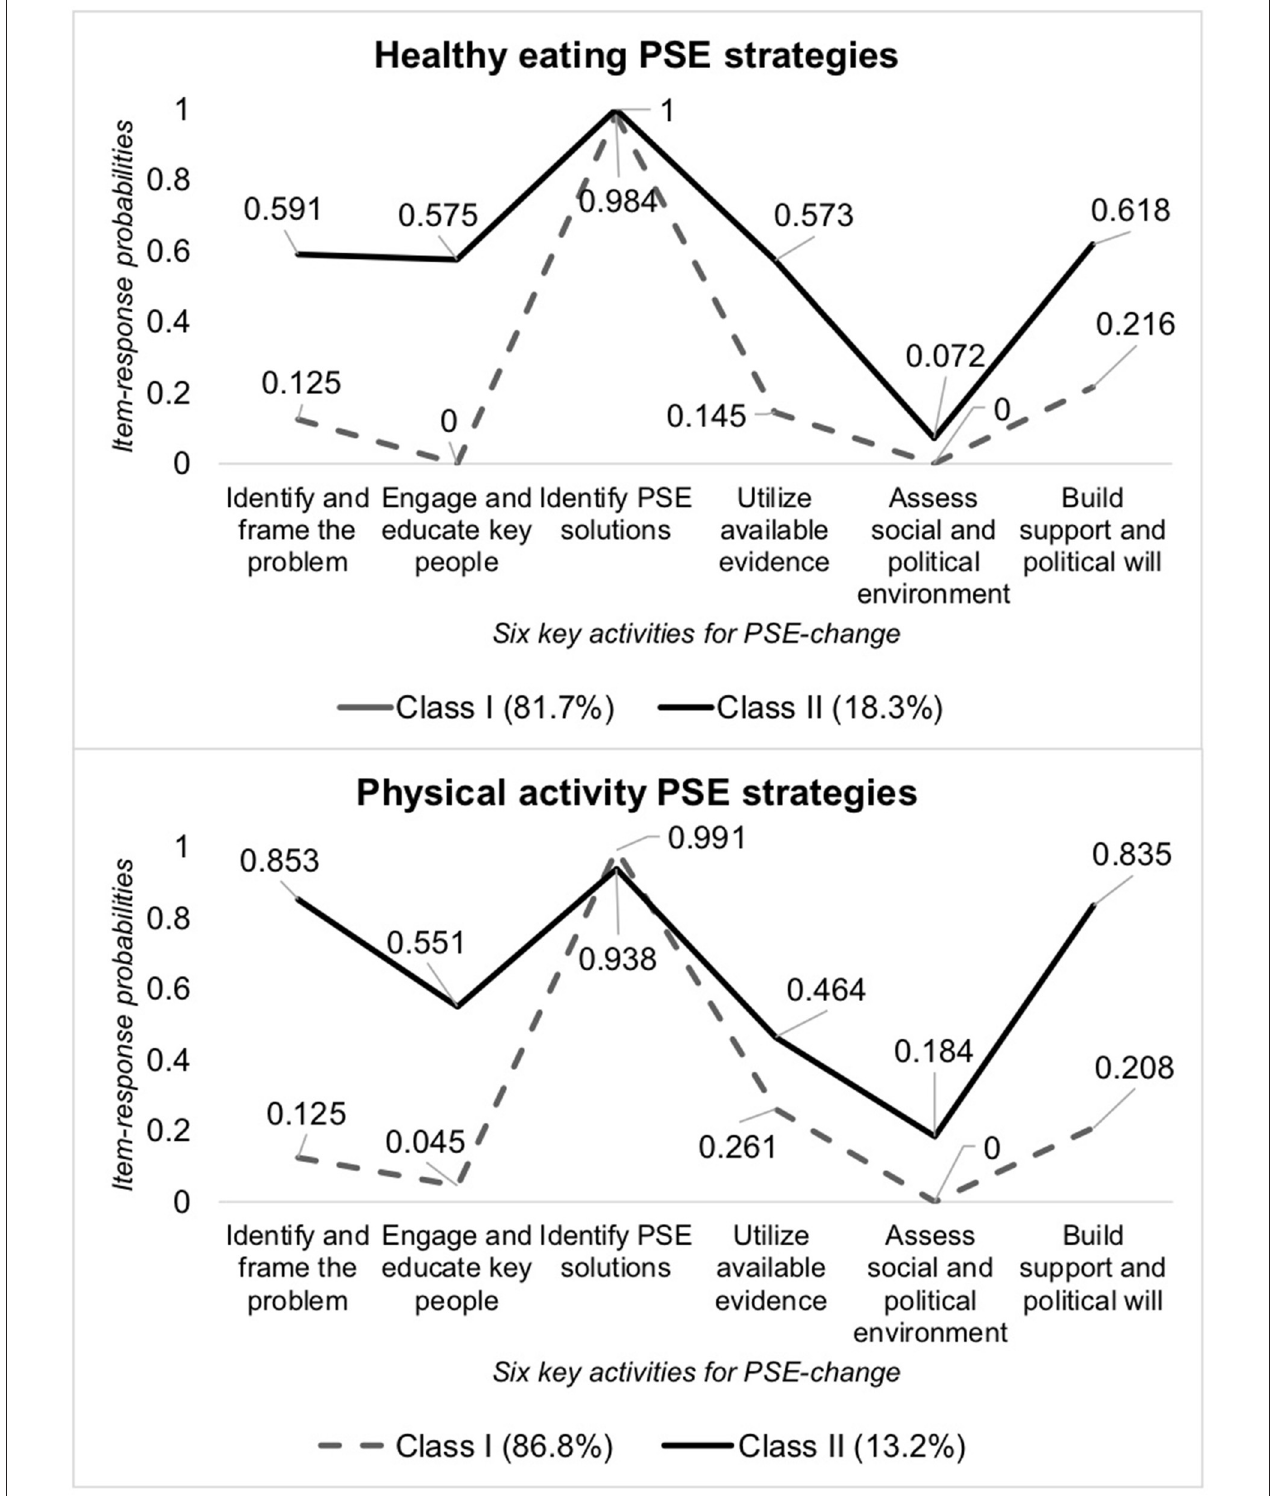
FIGURE 1 | Item-response probabilities of PSE strategy alignment with key activities by strategy class. PSE, policy, systems, and environmental approaches.